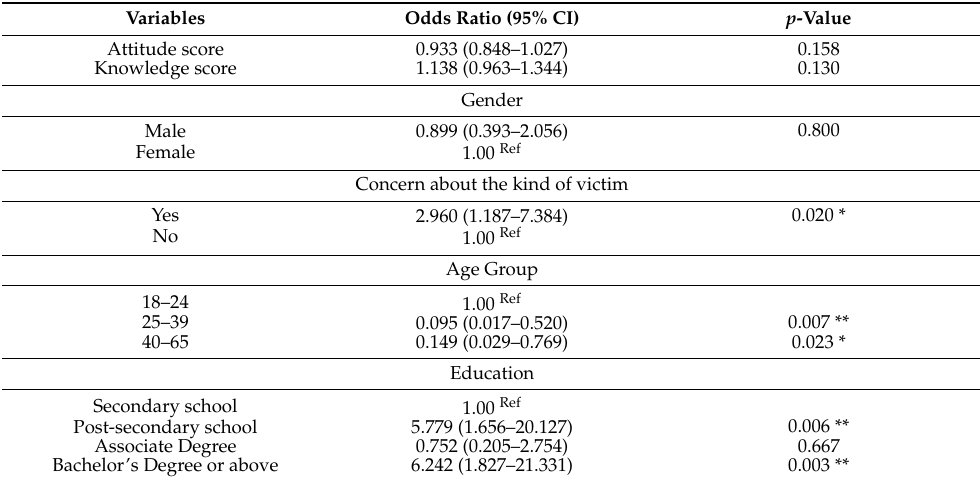
Table 2. Binary Logistic Regression Analysis on the predictors of ‘Worry about taking on